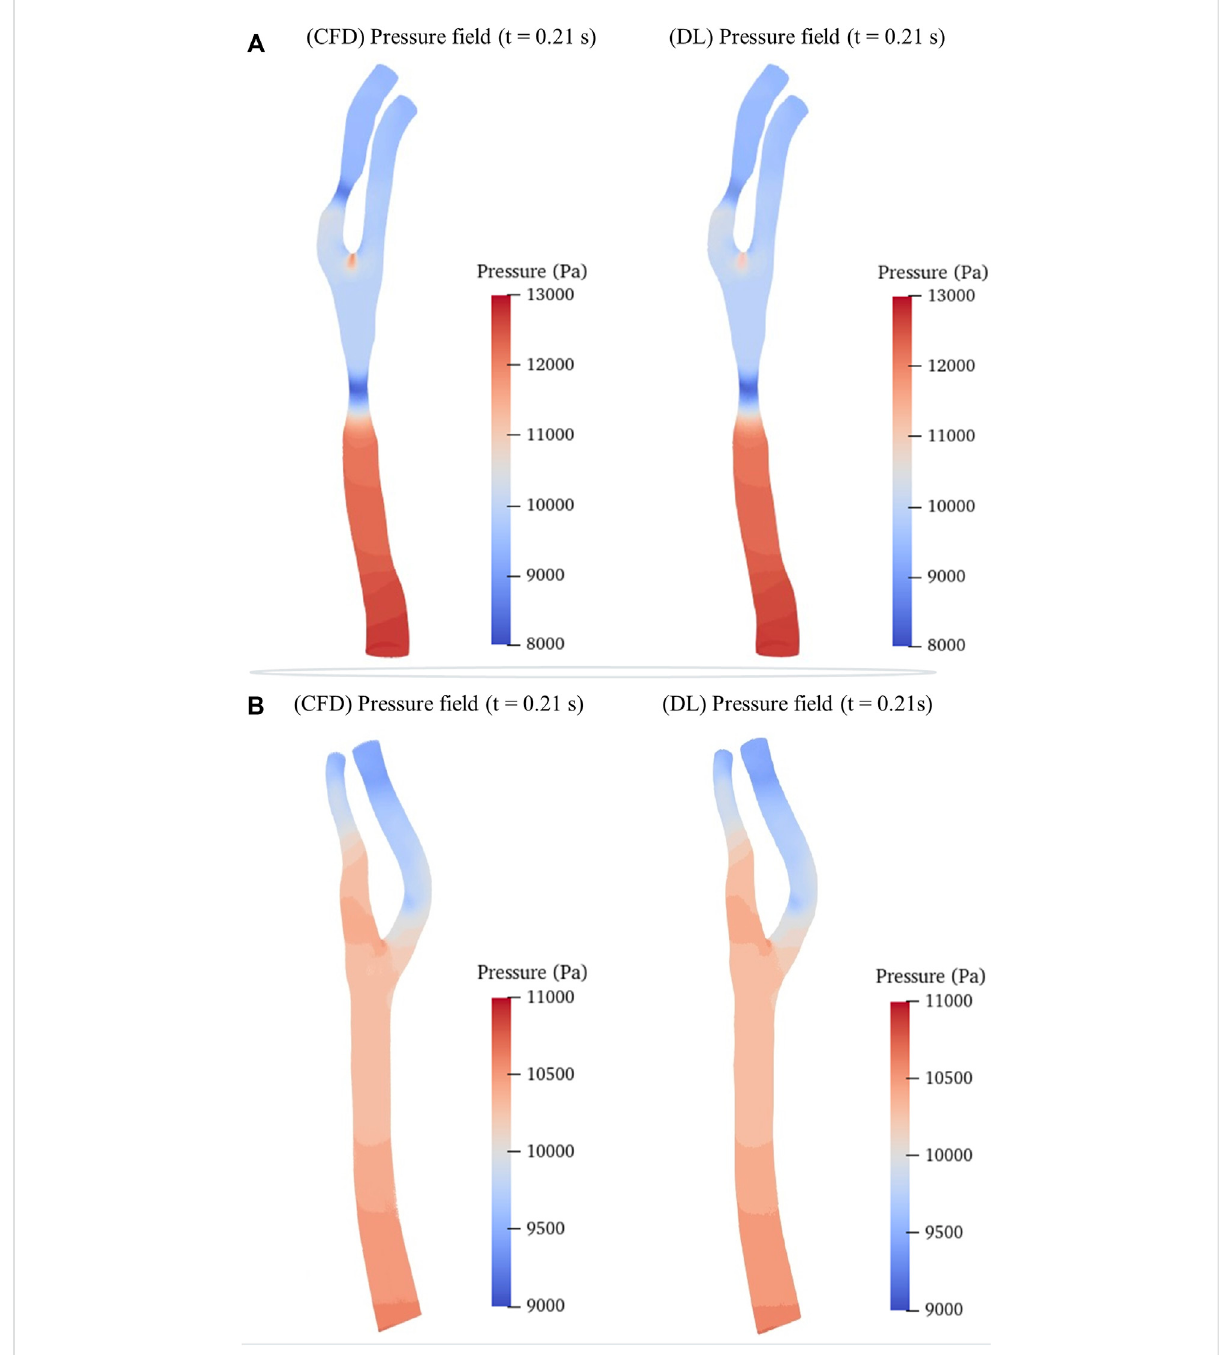
FIGURE 5 Comparison of pressure fi elds between CFD simulation and DL prediction. (A) . Carotid stenotic artery model; (B) . Carotid artery model without stenosis (cavity changed